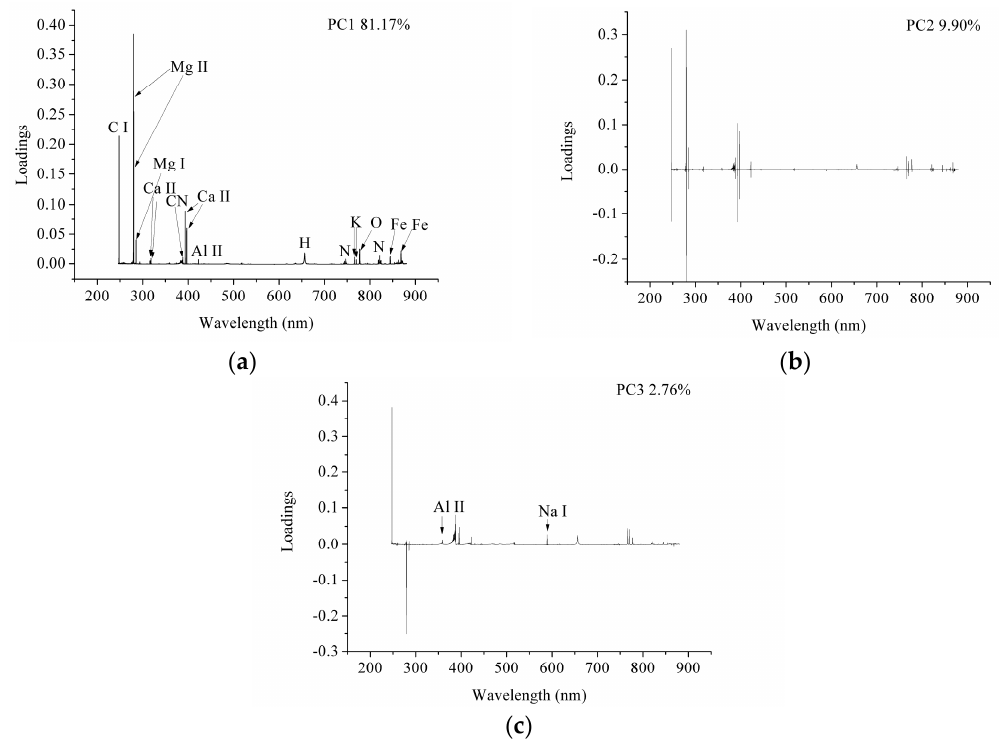
Figure 4. The loading plots of the first three PCs, ( a ) PC1, ( b ) PC2, and ( c ) PC3 for the 4 coffee varieties. Table 2. The spectral lines selected by PCA loadings and the corresponding element assignments.